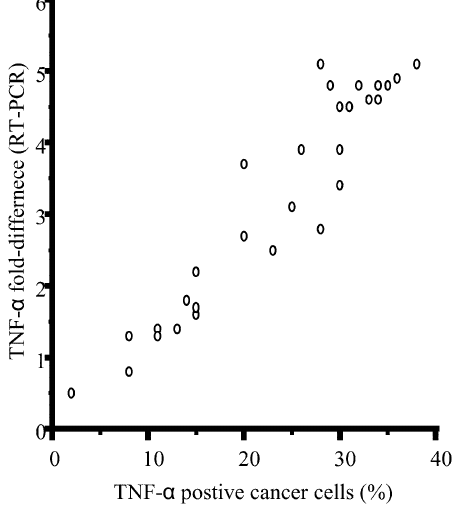
Fig. 2. Correlation of TNF- α protein and gene expression in CRC: TNF- α protein and gene expression show a strong positive corre- lation among the 31 colorectal cancer patients under investigation ( τ = 0 .